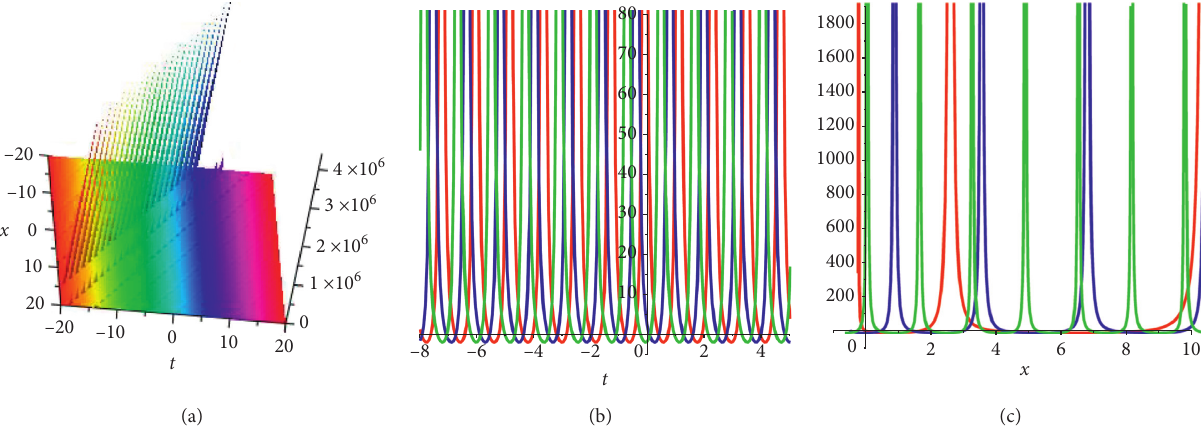
Figure 5: The plot of (96) Ψ plot (red α � 0 . 5, blue α � 0 . 75, and green α � 0 . 99).